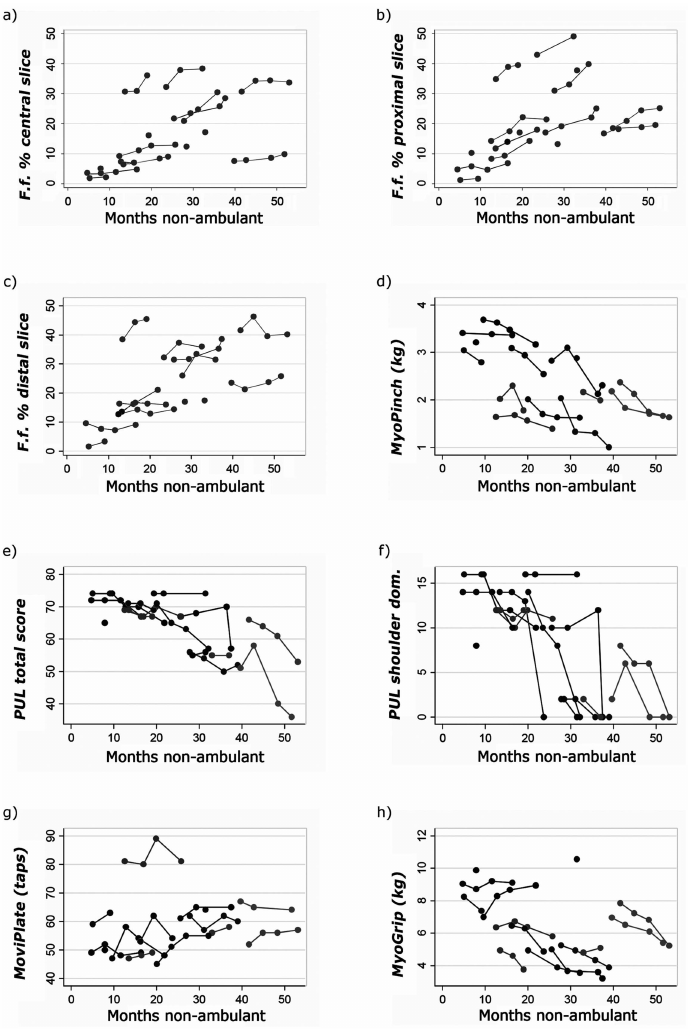
Fig 3. Plots of individual trajectories for (A) central slice overall muscle %fat fraction, (B) proximal slice overall muscle %fat fraction, (C) distal slice overall muscle %fat fraction, (D) MyoPinch, (E) total score for Performance of Upper limb, (F) PUL Shoulder domain score, (G) MoviPlate and (H) MyoGrip. f.f. = fat fraction. PUL = Performance of upper limb.